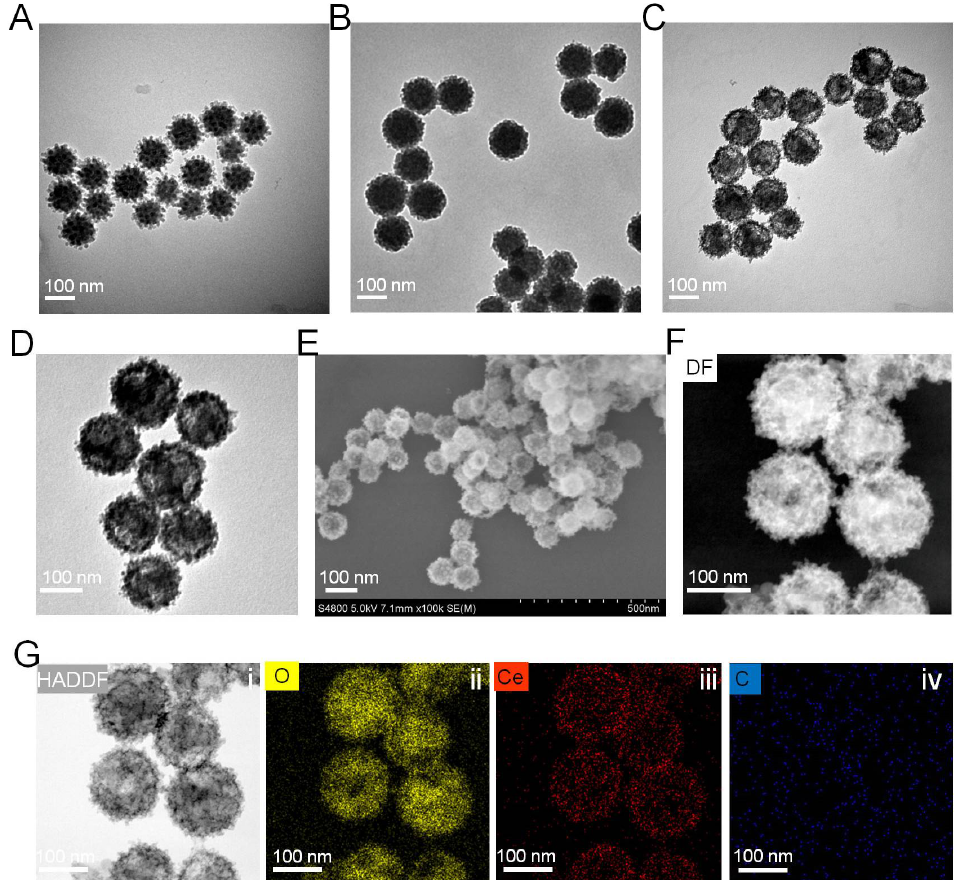
Figure 2. TEM images of virus-like mesoporous silica ( A ), CeO 2 coated mesoporous silica ( B ), HCeO 2 nanoparticles ( C ), and HCeO 2 @ICG-RGD ( D ). SEM images of HCeO 2 @ICG-RGD ( E ). Dark field ( F ), HADDF ( Gi ), O ( Gii ), Ce ( Giii ), C ( Giv ) elemental distribution images of HCeO 2 @ICG- RGD.